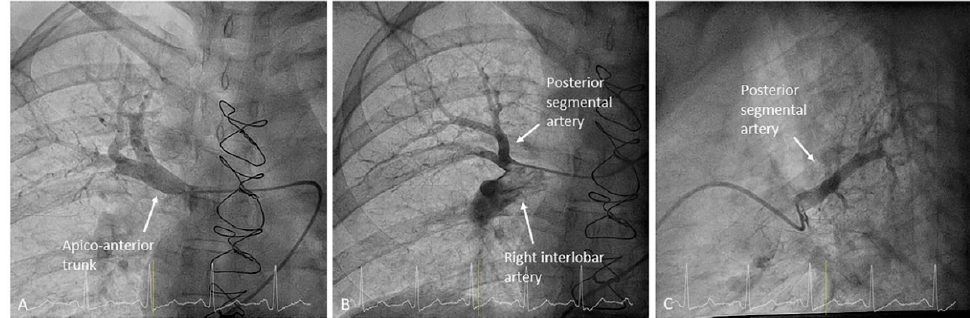
Figure 7. Right upper lobe branches: ( A ) apico-anterior trunk (A1/3) and ( B , C ) posterior segmental